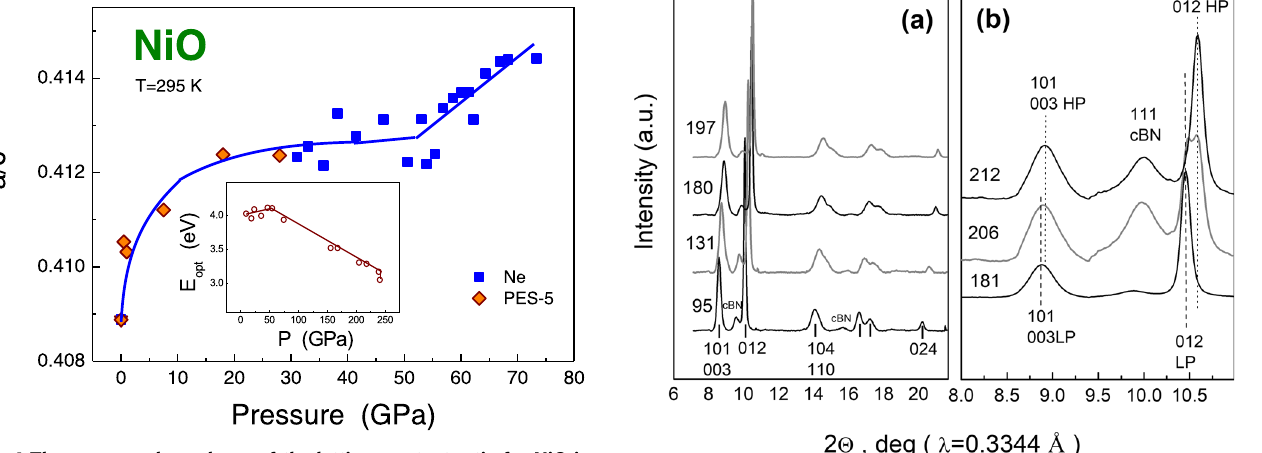
Fig. 4 The pressure dependence of the lattice constant ratio for NiO in hydrostatic and quasi-hydrostatic experiments at room temperature. The values of lattice constant ratio a/c calculated from X-ray diffraction for NiO in hydrostatic (run2) and quasi-hydrostatic (run1) experiments are shown in bluesquares and orange diamonds. There is a kink at~55GPa which isrelated to the kink in the pressure dependence of the optical gap (shown in inset) 8 .